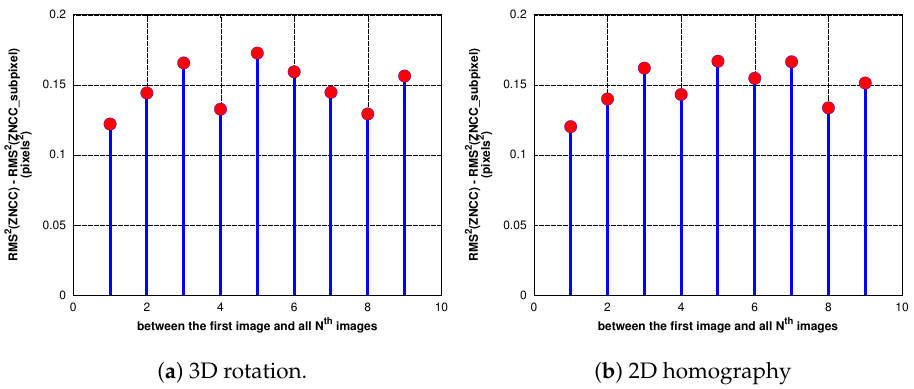
Figure 15. RMS 2 difference between ZNCC without sub-pixel and ZNCC with sub-pixel accuracy.